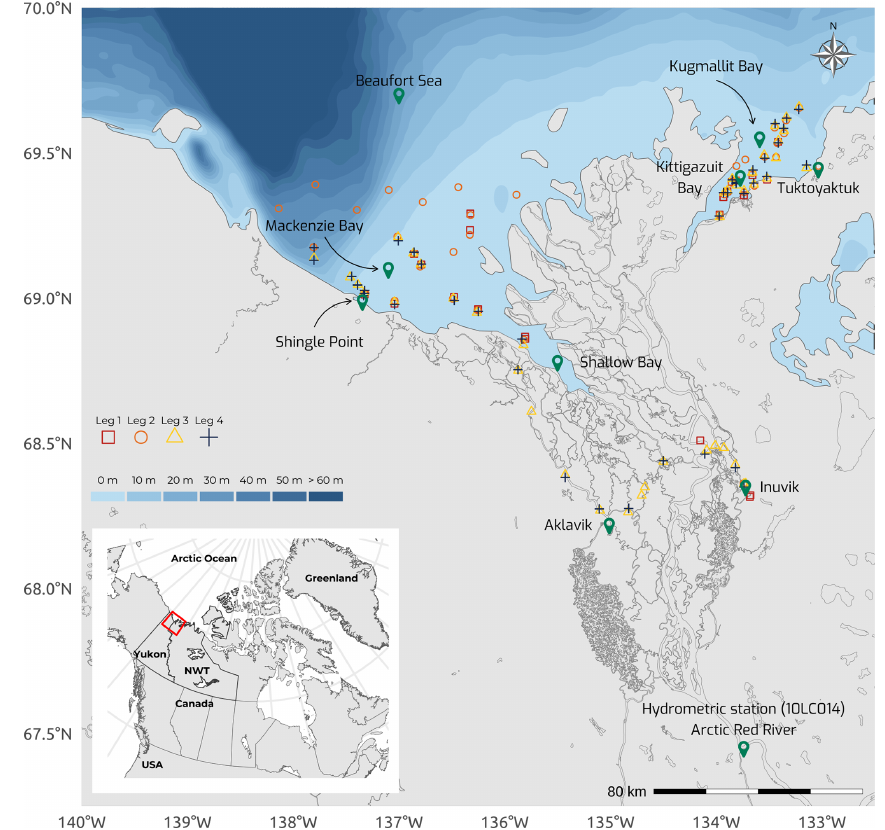
Figure 1. Map of the Mackenzie Delta region (Inuvialuit Settlement Region, Northwest Territories, Canada), with bathymetric features (from 0 to > 60m) of the coastal waters of the southern Beaufort Sea, showing the sampling stations during the four 2019 WP4 Nunataryuk field expeditions (Legs 1, 2, 3, and 4). Note that the Arctic Red River hydrometric station (10LC014) used to retrieve discharge rates (Fig. 3a) is shown. Leg 1 took place from 17 April to 3 May 2019, Leg 2 extended from 14 June to 4 July 2019, Leg 3 took place from 25 July to 8 August 2019, and Leg 4 was conducted from 26 August to 9 September 2019.